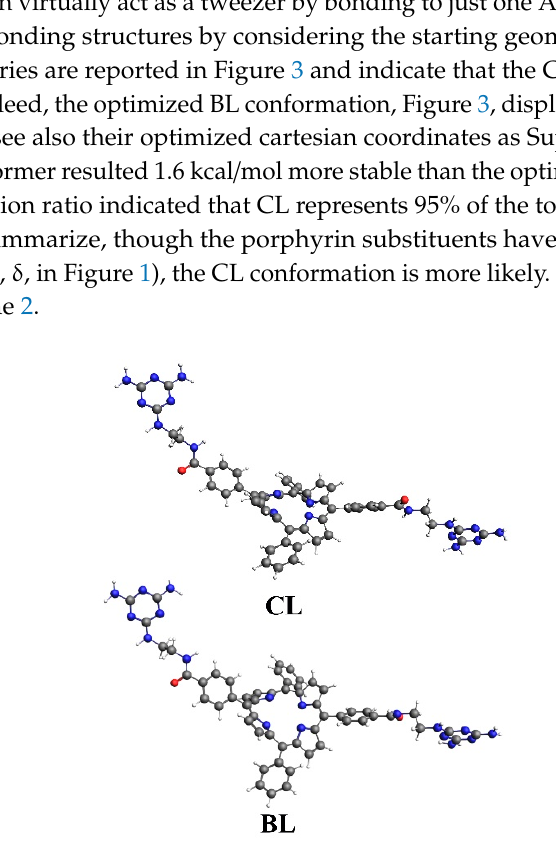
Figure 2. Starting geometries of the chair-like (CL) and as boat-like (BL) conformations.